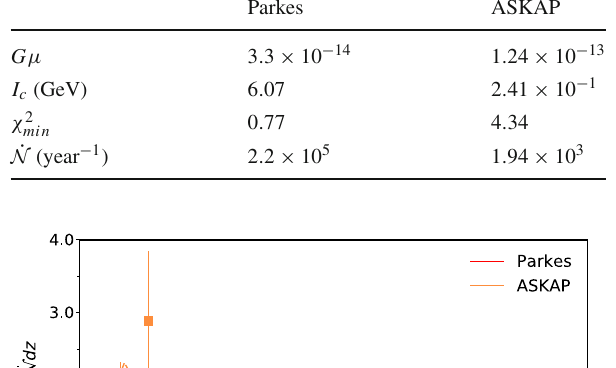
are provided min Parkes